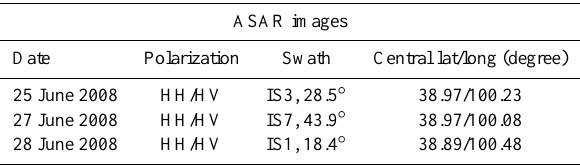
Table 4. List of ASAR images used in this Figure 2. The three-level soil moisture field sampling strategy.